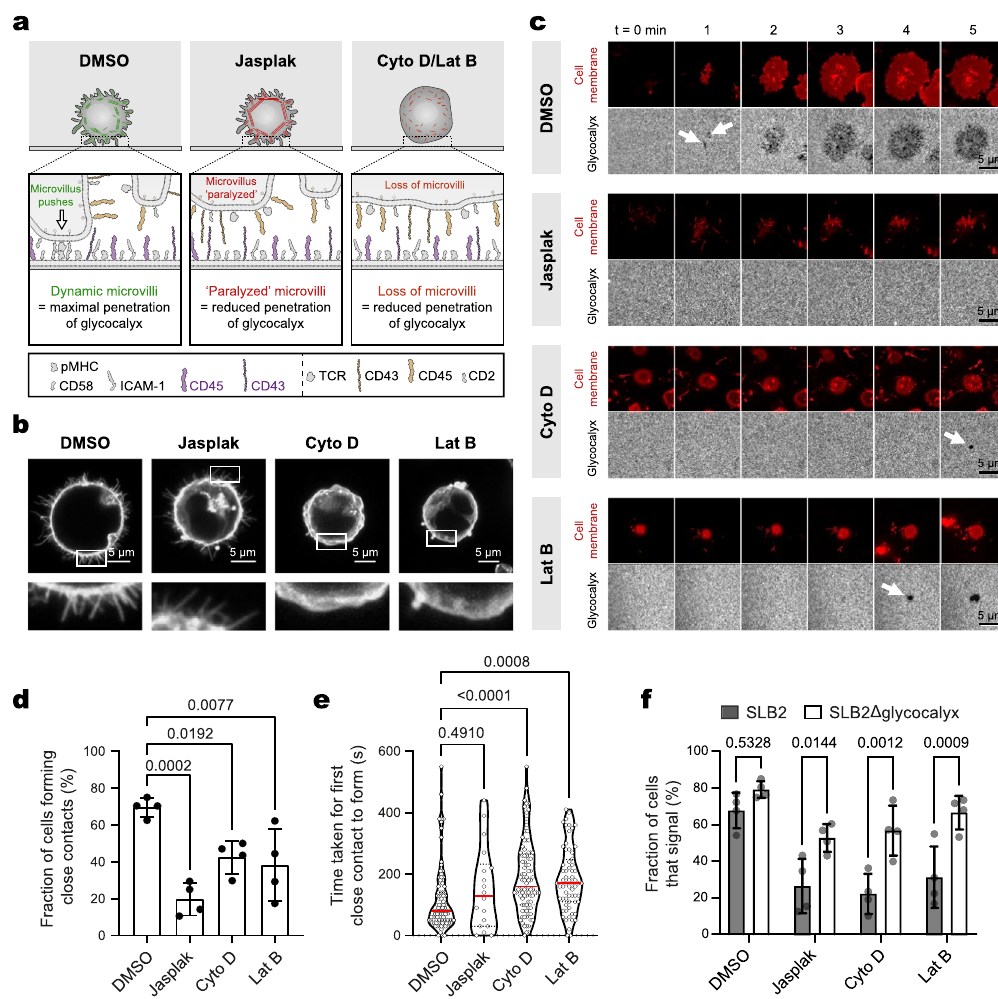
Fig. 2 | Microvilli allow T cells to overcome a glycocalyx barrier. a Cartoon depictionofexperimentstestingwhetherdynamicactinremodelingofmicrovilliis needed to establish close-contacts in the presence of a glycocalyx barrier. Jaspla- kinolide (Jasplak) enhances the nucleation and stabilization of actin fi laments, resultingin ‘ paralysis ’ oftheactincytoskeletonandmicrovillaractivity.Latrunculin B (Lat B) and cytochalasin D (Cyto D) prevent the formation of actin fi laments by sequestering actin monomers and by blocking their recruitment to pre-existing fi laments, respectively, resulting in fi lament breakdown and subsequent loss of membrane topography. Cells in the cartoon are shown interacting with an SLB2. b Confocal fl uorescence images of fi xedJ8-GECIcellsimaged atthe midplane after treatment with DMSO or an actin-modifying drug. A digitally-magni fi ed region (white box) is shown below. Images are representative of J8-GECI cells for n =3 independent experiments. c Examples of contact formation in the presence of DMSO or the actin-modifying drugs, for J8-GECI cells interacting with an SLB2 presenting pMHC null plus pMHC 9V-lo , i.e., ~1 pMHC 9V molecule/ μ m 2 . Close contacts are indicated by black holes in the SLB2 glycocalyx fl uorescence (with point of